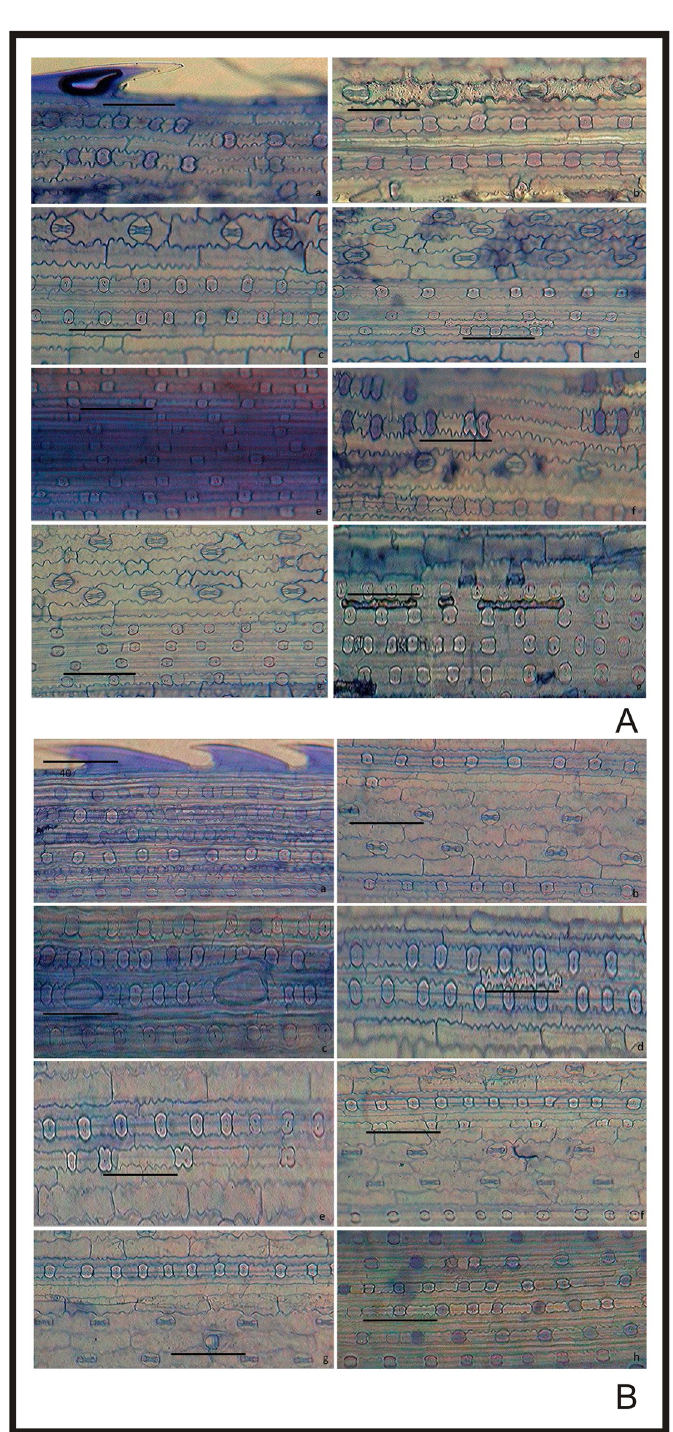
Fig 2. In-situ location of phytoliths in leaf epidermis of Acrachne racemosa (Heyne ex Roem. & Schult.) Ohwi. A. Adaxial surface (a-h) B. Abaxial surface(a-h); bar = 40 μ m.